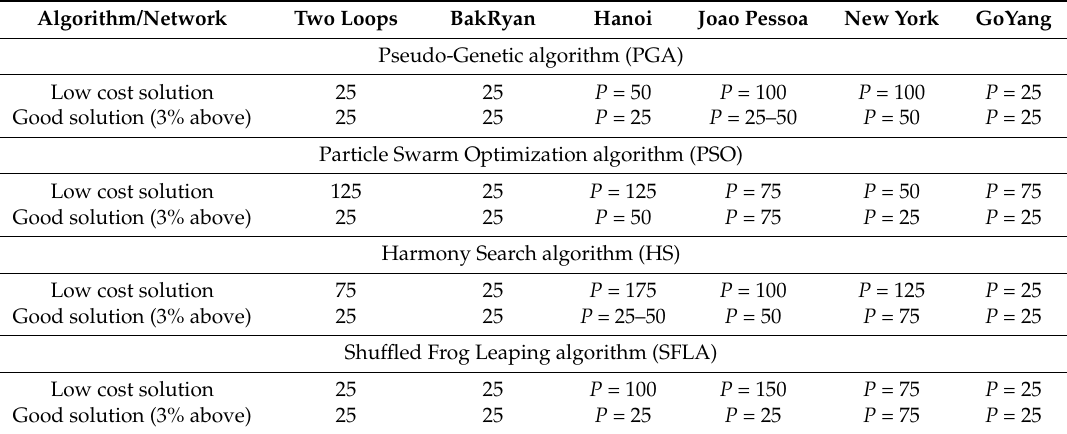
Table 3. Optimal initial random population size P calibration for the considered